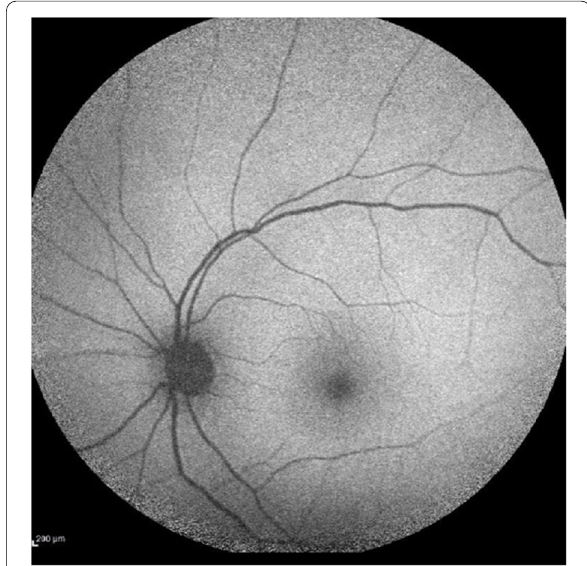
Fig. 3 Normal fundus autofluorescence (FAF) of the left eye at first presentation. FAF of the right eye c not be obtained because of hazy